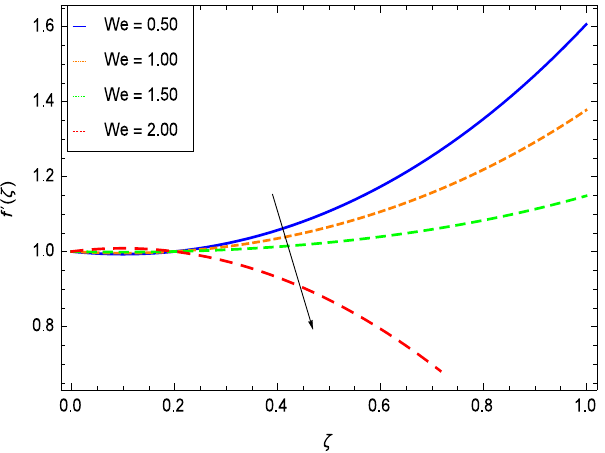
Figure 9. Flow layer at h = − 3.00, β = 0.10, φ = 0.40, M = 2.00, n = 1.50, S = 0.50, A = π enhancement in We